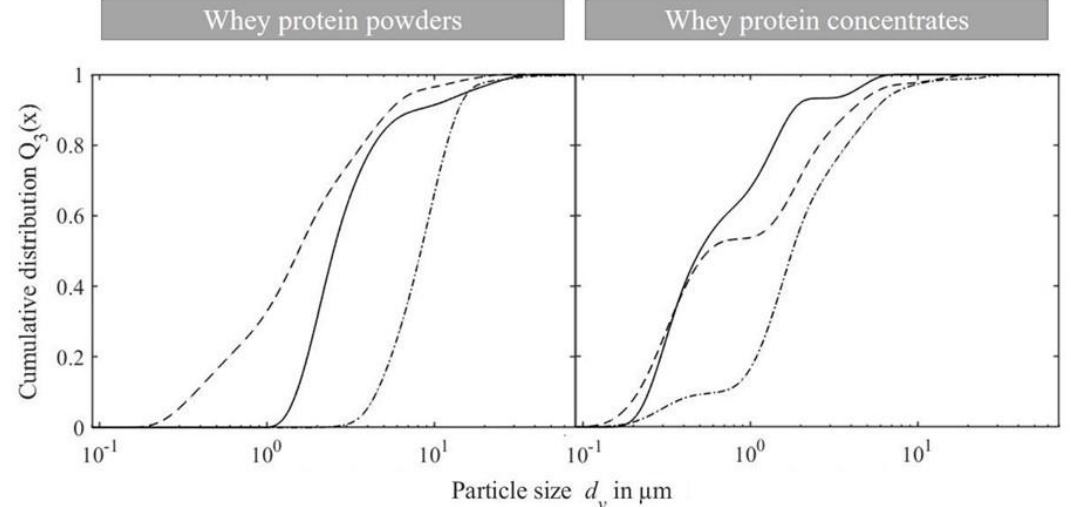
Figure 5. Particle size distributions of whey protein pectin complex dispersions prepared with whey protein powders WPI nzmp (solid line), WPI SaM (dash dot line), WPC SaM (dashed line) and whey protein concentrates W tech (dashed line), W ideal (dash dot line) and W ind (solid line) as whey protein sources mixed with pectin, followed by thermomechanical heat treatment (90 ◦ C, 675 s − 1 , 19.5